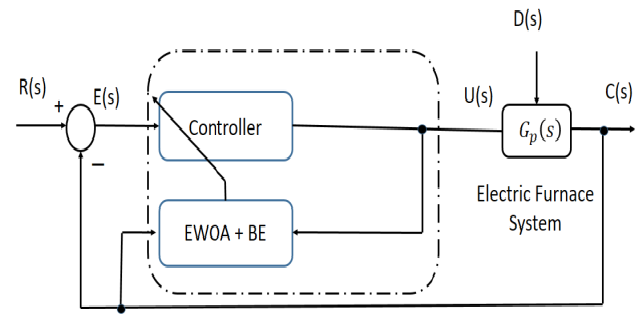
Figure 4. The overall temperature control system.